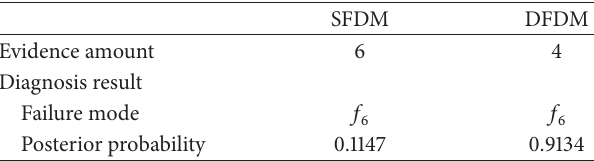
Table 5: Diagnosis process comparison between SFDM and DFDM in Case